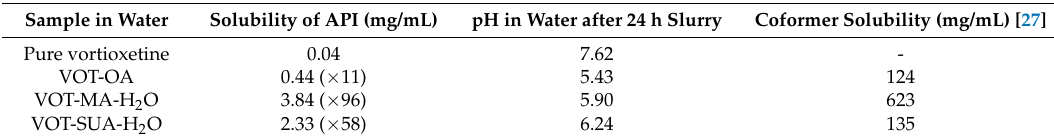
Table 3. Powder solubility test results ( n = 3).